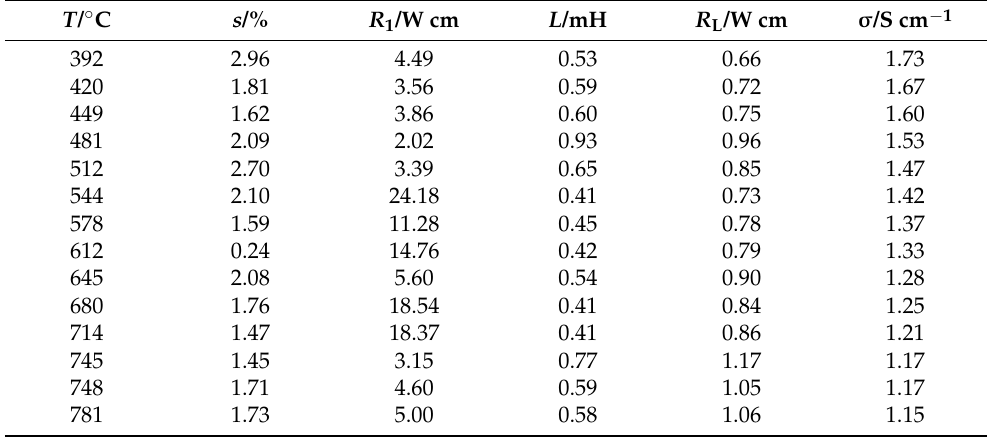
Table 5. Results of fitting the impedance spectra recorded for Ni–5CBCY samples at different temperatures during heating ( T —temperature; s —standard deviation; fitted parameters (for the EEC presented in Figure 14b): L —inductance; R L and R 1 —resistances; σ —electrical conductivity).